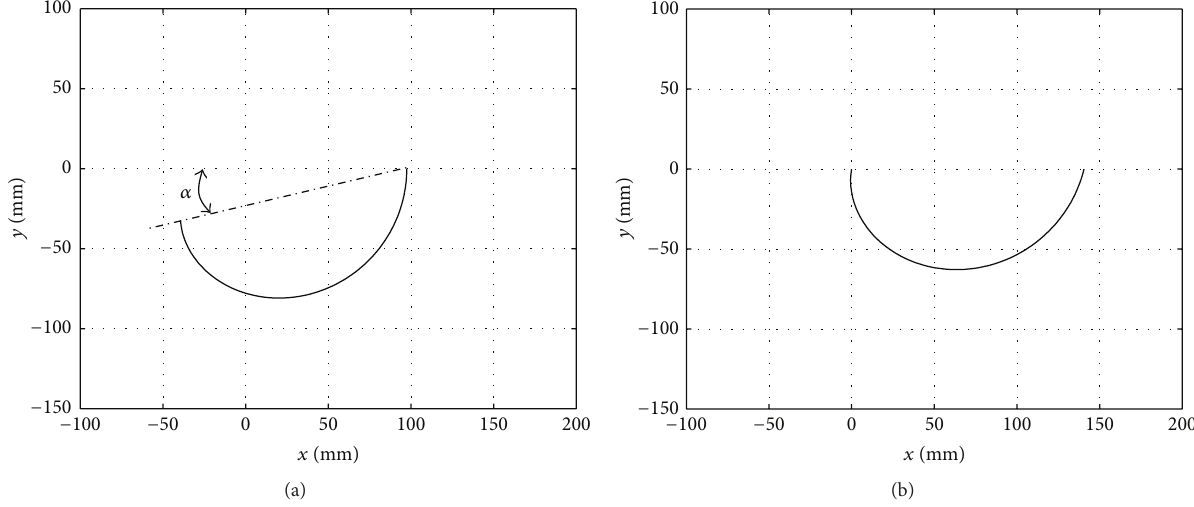
Figure 5: Flexoextension path: (a) rotation angle 𝛼 and (b) rotated